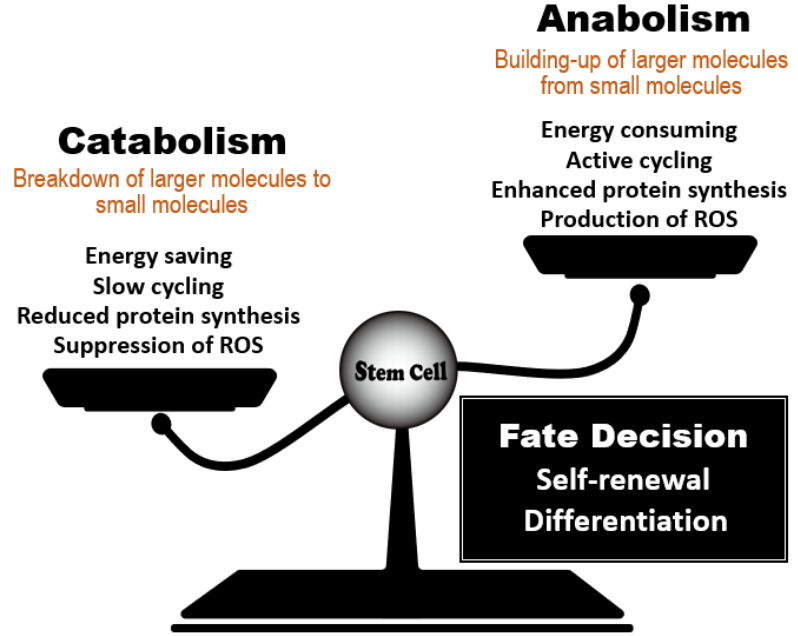
Figure 1. Regulation of stem cell fate decisions by the anabolic/catabolic balance. Stem cell behavior is influenced by a balance between regulators of catabolic and anabolic metabolic reactions. Dominance by catabolic regulators, which act to reduce energy use, protein synthesis and ROS accumulation, favors stem cell quiescence and the steady-state. When anabolic regulators gain dominance, active cycling by a stem cell increases its energy consumption and protein synthesis, enabling the cells to undertake the decision to either self-renew or differentiate. The anabolic/catabolic balance thus has a major influence on stem cell homeostasis.